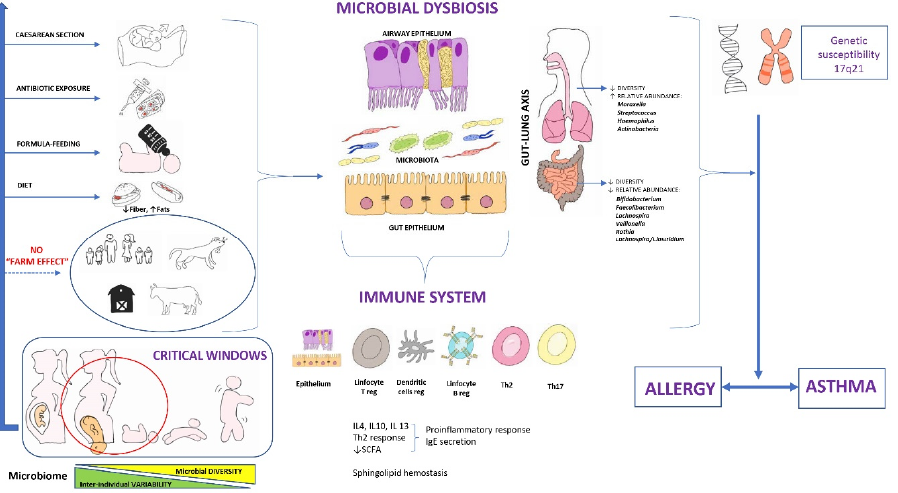
Figure 1. Microbial dysbiosis as an early origin of asthma. Modified and with permission from Valverde-Molina J [22].